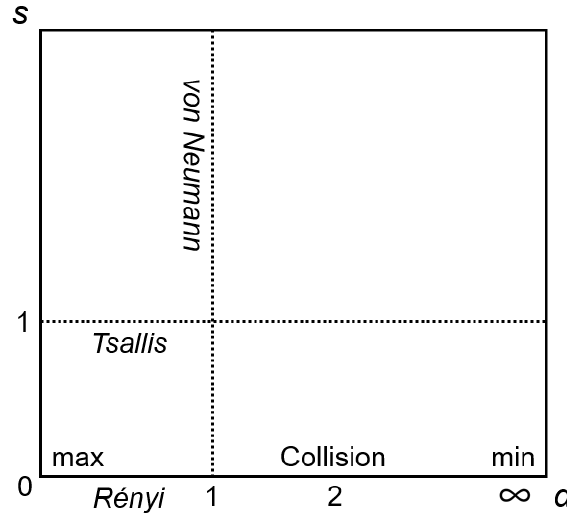
Figure 1 . Uni(cid:12)ed ( (cid:11); s )-entropies, (cid:11) > 0 ; s (cid:21) 0. Italicized names refer to the whole